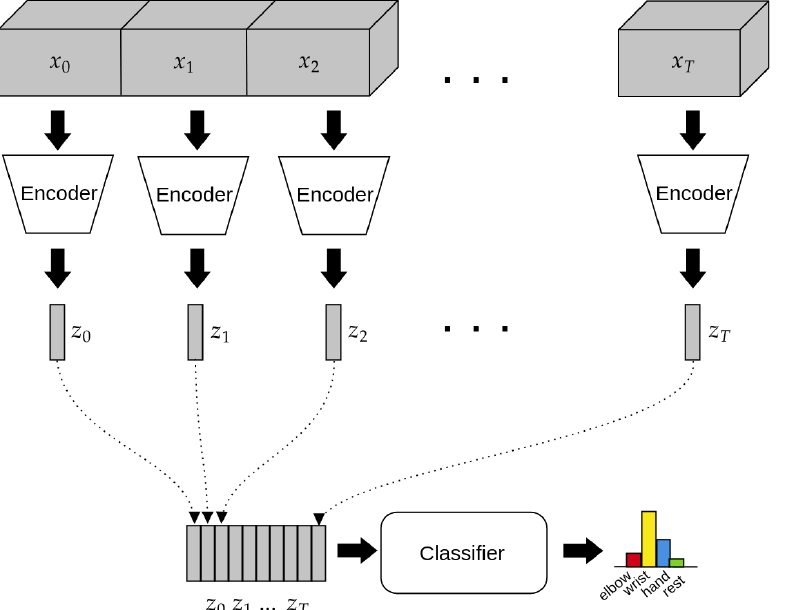
Figure 2. Schematic view of the architecture of the model. Each chunk of input data x i is a sequence of 32 timesteps, with input channels arranged according to Table 1. The Encoder (a 3D convolutional neural network, see Section 2.4.1) processes each input chunk sequentially, producing a series of compressed codes z i as a results. The code sequence is then passed to the Classifier, implemented as a long short-term memory (LSTM) network (see Section 2.4.2), which outputs the final classification at each timestep. Table 2. List of layers that compose each module of the model. Layers name and parameters.